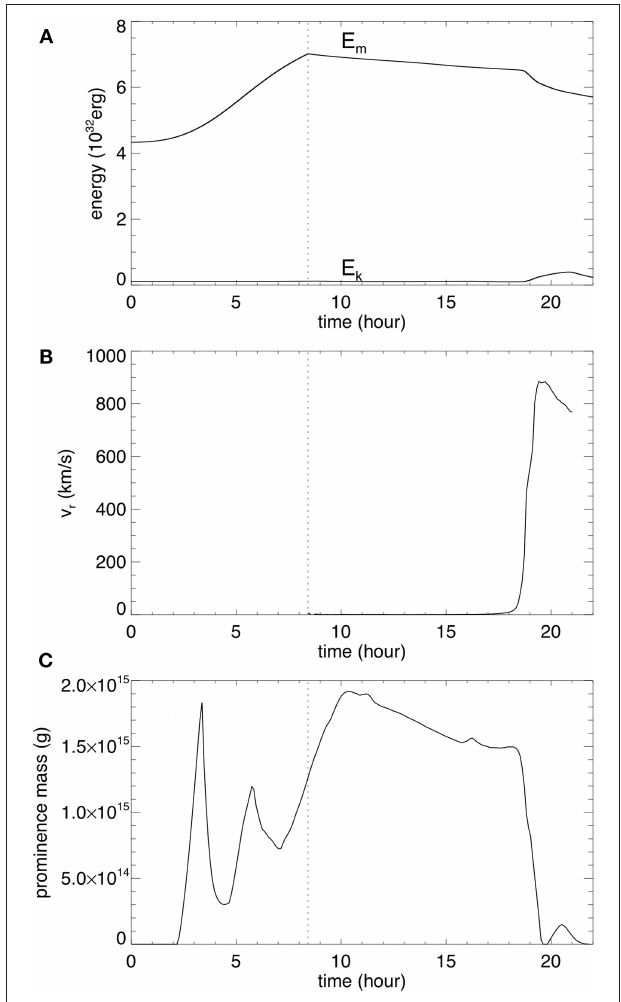
FIGURE 3 | (A) The evolution of the total magnetic energy E m and total kinetic energy E k , (B) the evolution of the rise velocity at the apex of the axial field line of the emerged flux rope, and (C) the evolution of the cool prominence mass in the corona evaluated as the total mass with temperature below 10 5